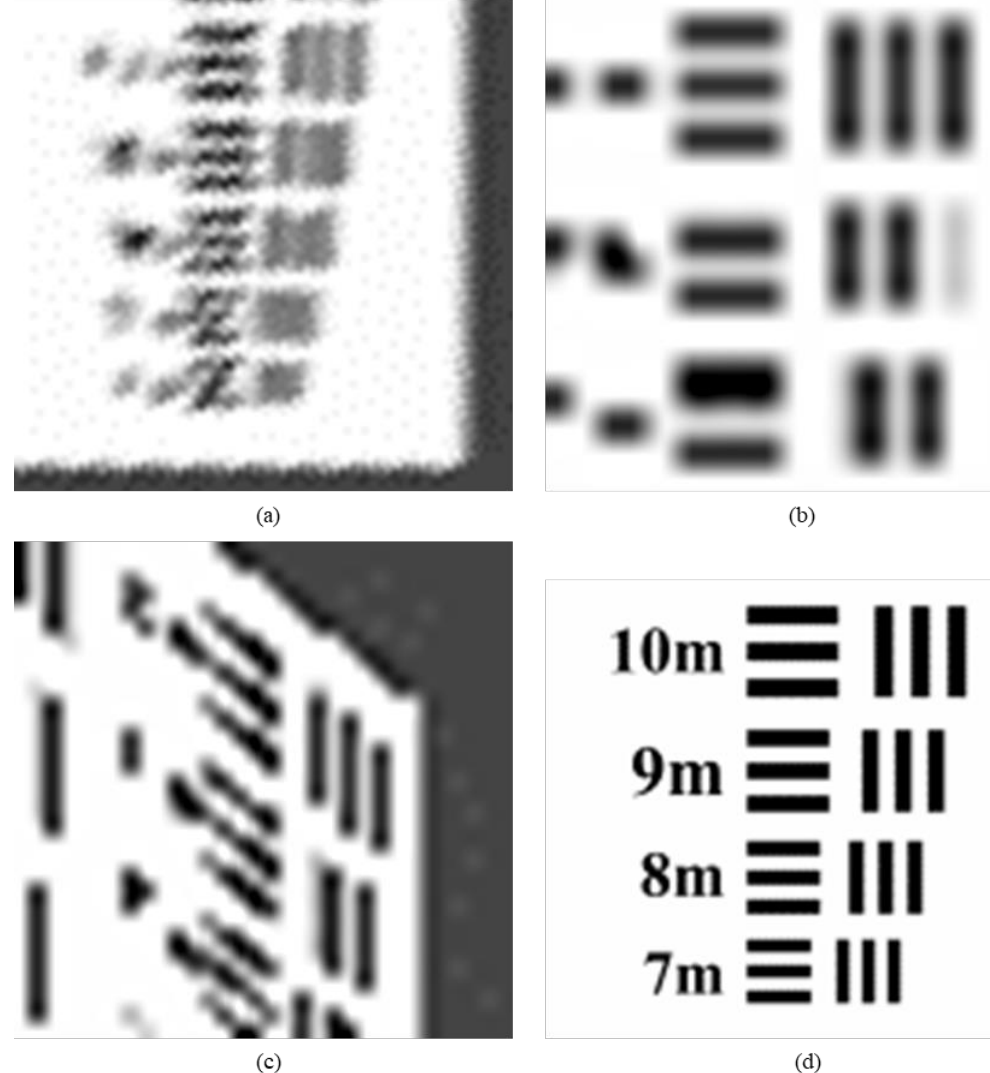
Figure 17. The local magnification of the target remote-sensing image: ( a ) super-resolution image, ( b ) conventional mode simulation image, ( c ) CMOS1 oblique-mode simulation images, ( d ) original high-resolution image.